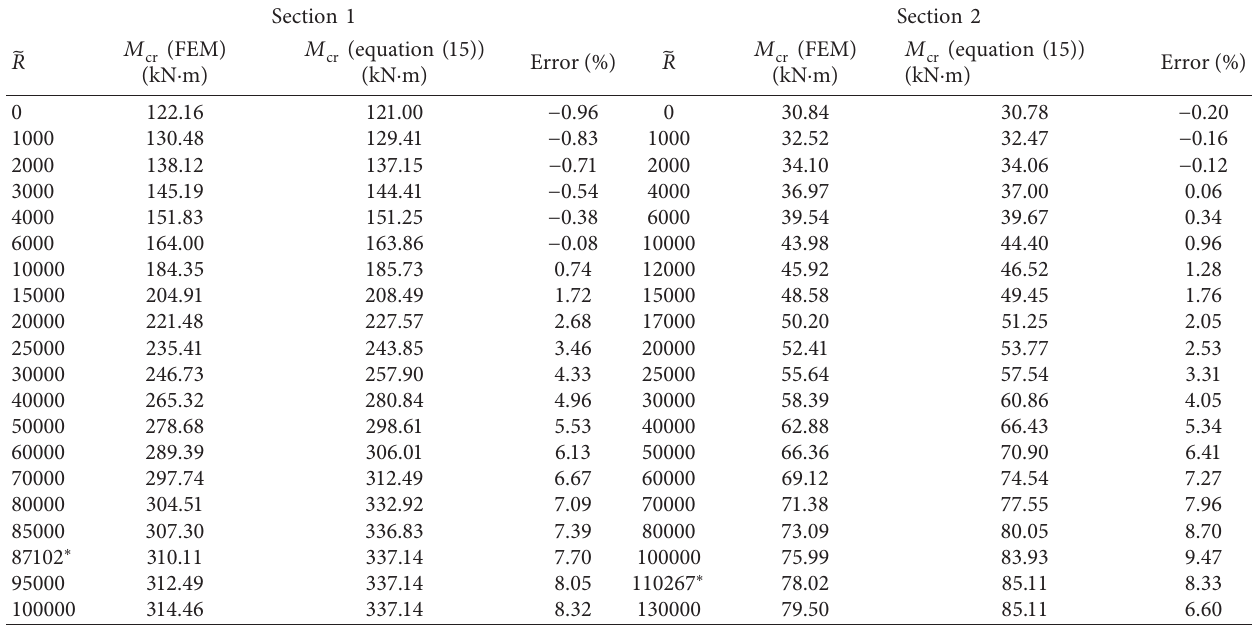
Table 8: Comparison of theoretical analysis and finite element analysis.